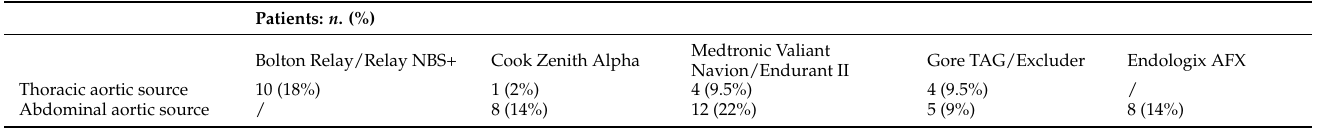
Table 3. Operative details: used endografts patients. Patients: n .